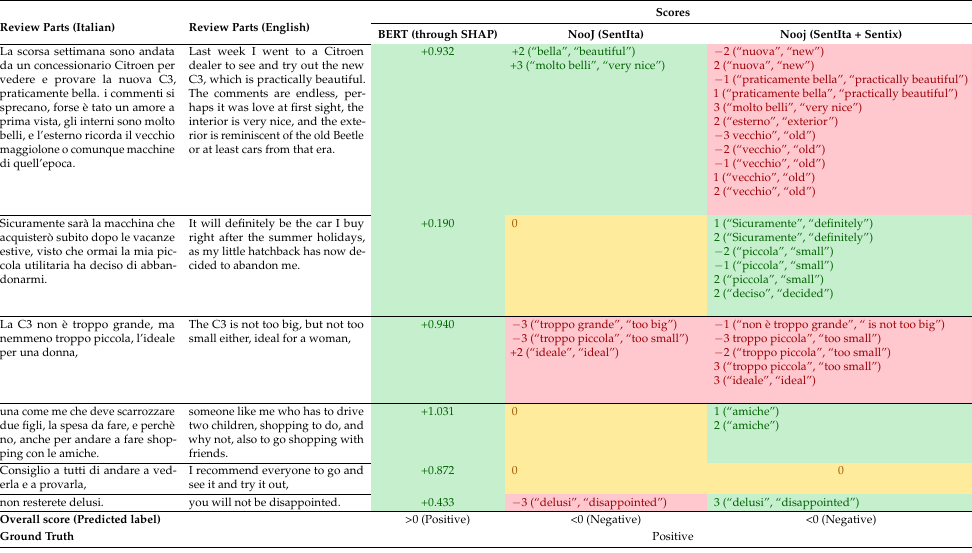
Table 10. Only BERT detects them correctly. Example